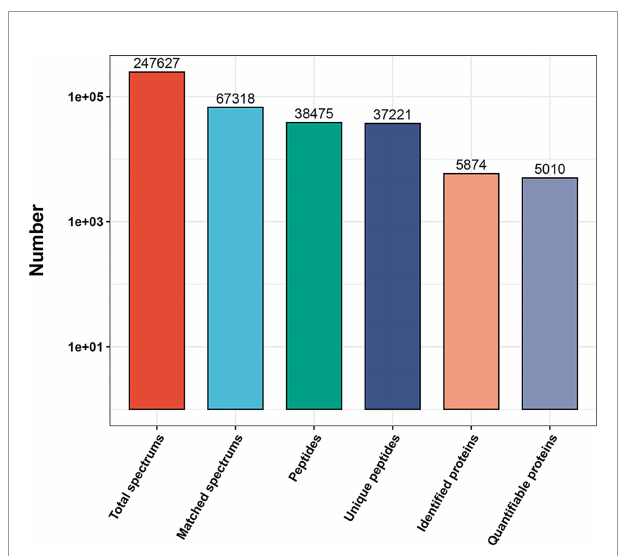
FIGURE 1 | Overview of the mass spectrometry results. Bar plot summarizing the detected peptides and proteins in Wt Thra +/+ ( n = 4) and Hom Thra E403X/E403X ( n = 5) mice.